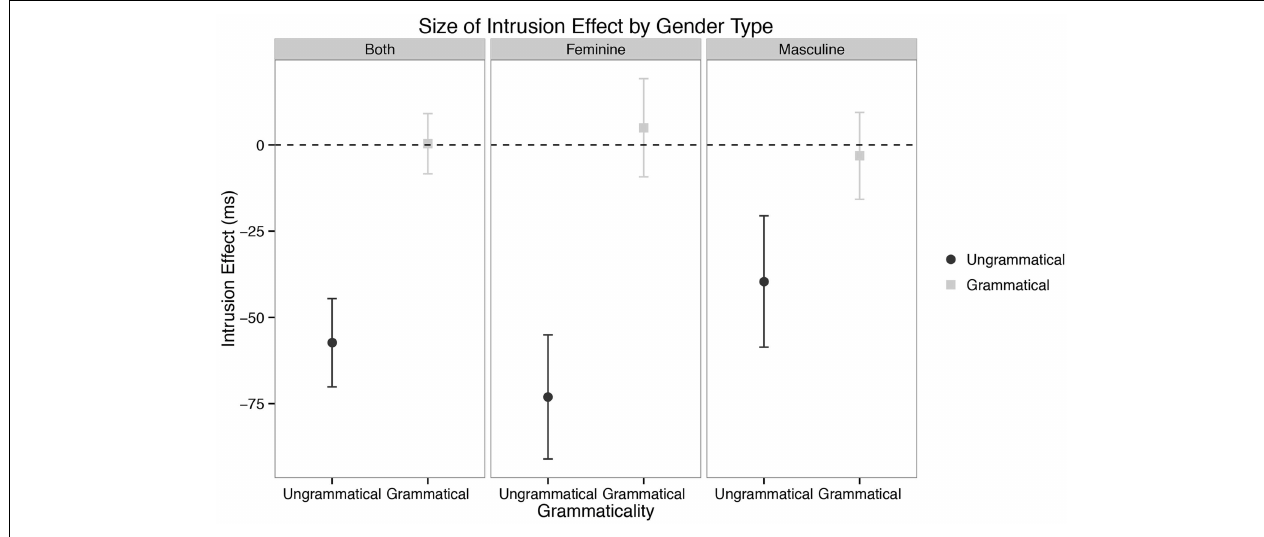
FIGURE 5 | Actual sizes of intrusion effects across different grammaticalities and gender/plural types in the self-paced reading data. Intrusion effects are computed by subtracting retrieval times in